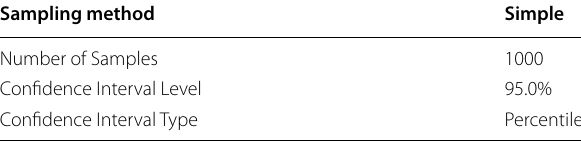
Table 2 Bootstrap re-sampling confidence interval